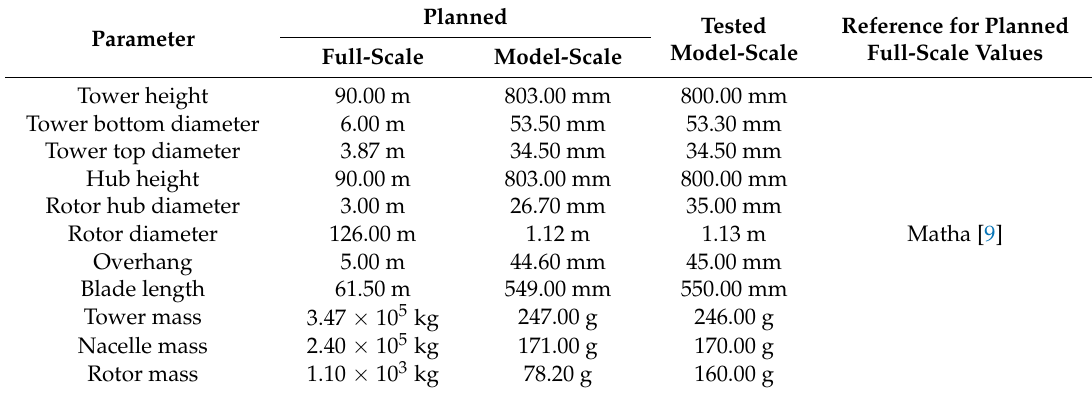
Table 2. ‘As constructed’ parameters of the scaled NREL 5 MW turbine.